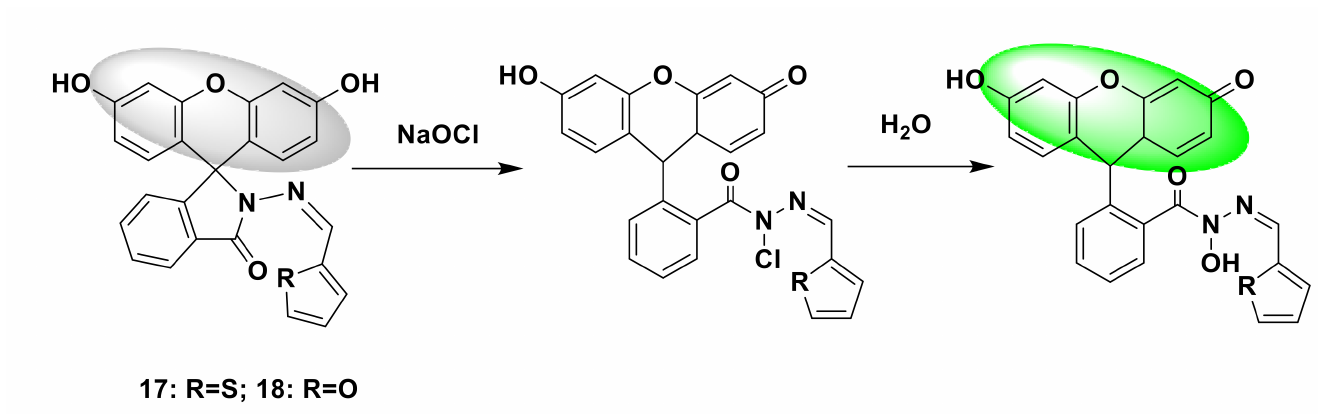
Figure 19. The reactions of probes 17, 18 and ClO −